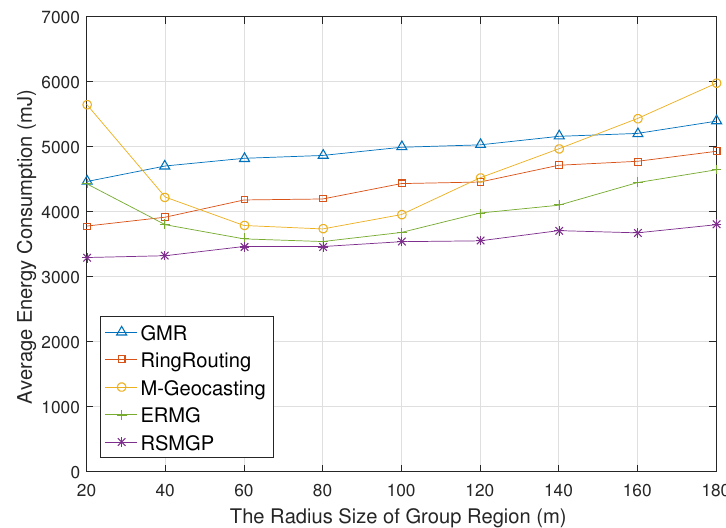
Figure 9. Energy consumption impacted by the radius of group area.